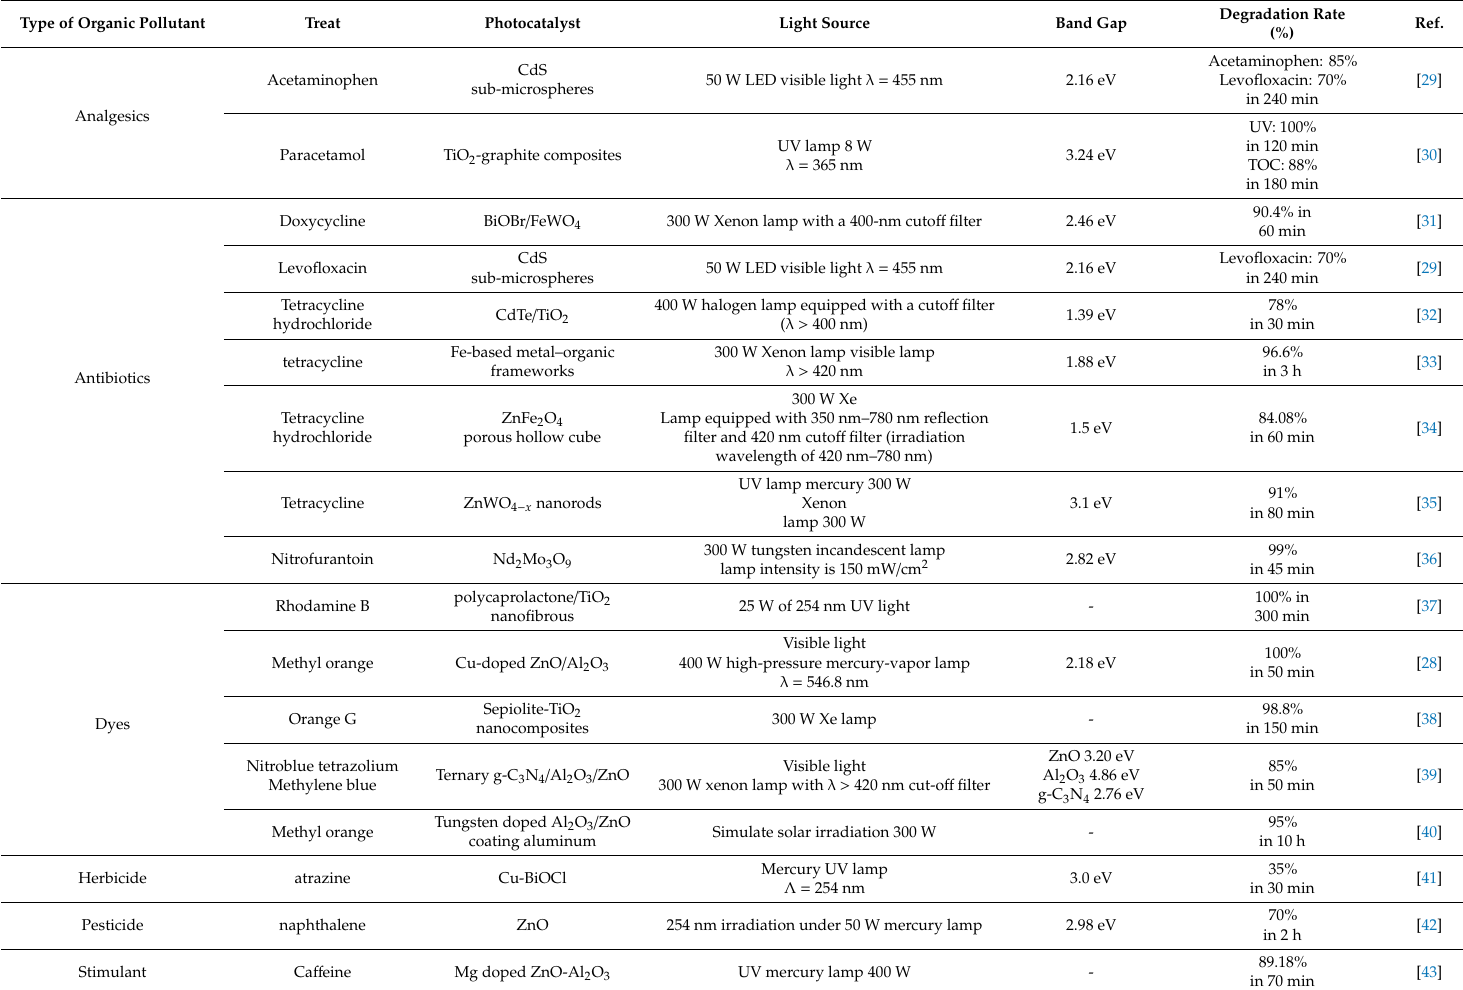
Table 1. Research on photocatalysis; parameter condition and results reported from 2016 to